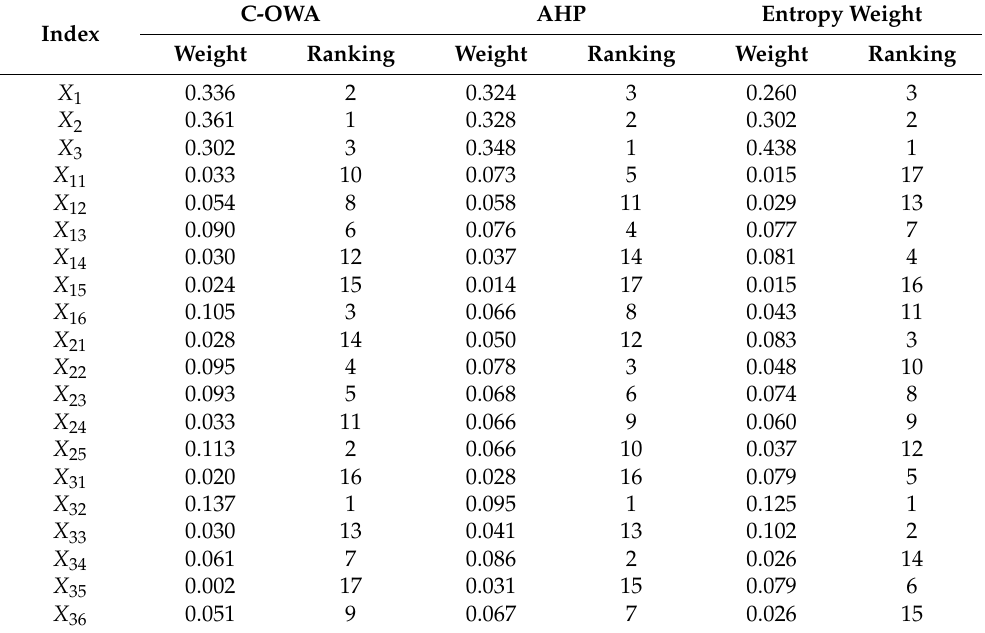
Table A9. Weight calculation results obtained by the three weight calculation